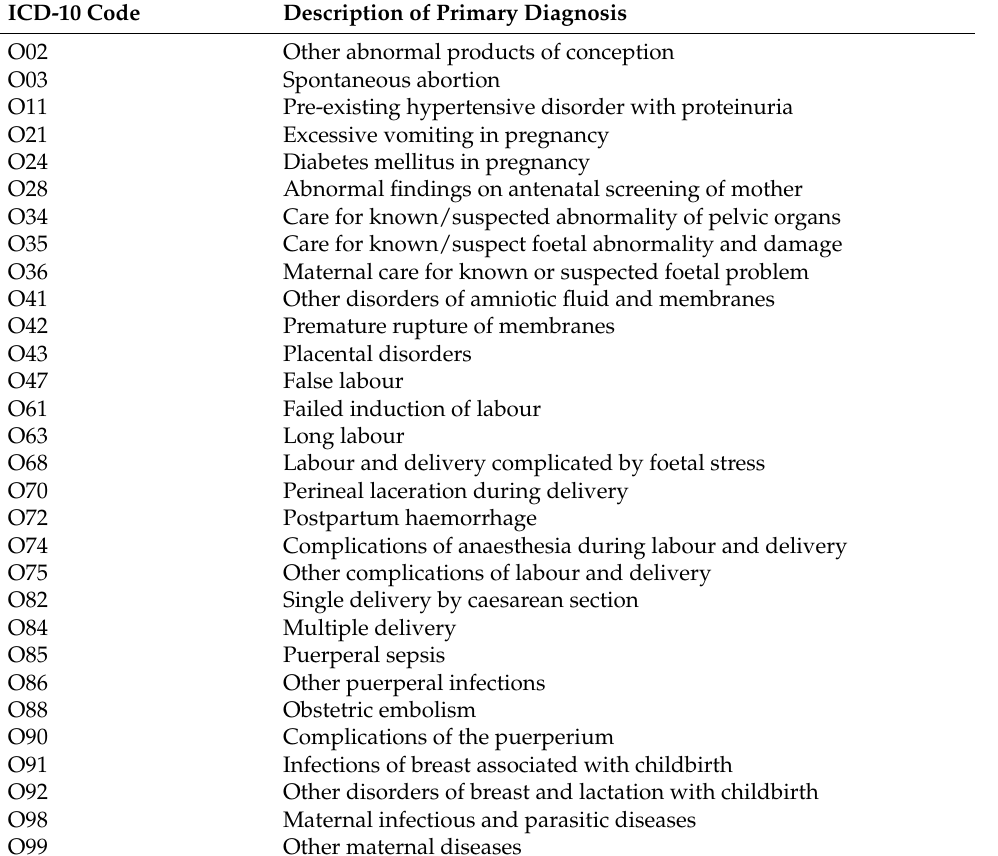
Table A3. ICD-10 primary diagnoses, which involve more complex pregnancy and births and collectively show unusual trends in average length of stay over time. This group of “affected” diagnoses was chosen based on peculiar trends in length of stay. After making the choice on this basis, it emerged that these were all more complex pregnancy and childbirth diagnoses. Data are from NHS Digital, Hospital Episode Statistics [69]. ICD-10 Code O02 Other abnormal products of conception O03 Spontaneous abortion O11 Pre-existing hypertensive disorder with proteinuria O21 Excessive vomiting in pregnancy O24 Diabetes mellitus in pregnancy O28 Abnormal findings on antenatal screening of mother O34 Care for known/suspected abnormality of pelvic organs O35 Care for known/suspect foetal abnormality and damage O36 Maternal care for known or suspected foetal problem O41 Other disorders of amniotic fluid and